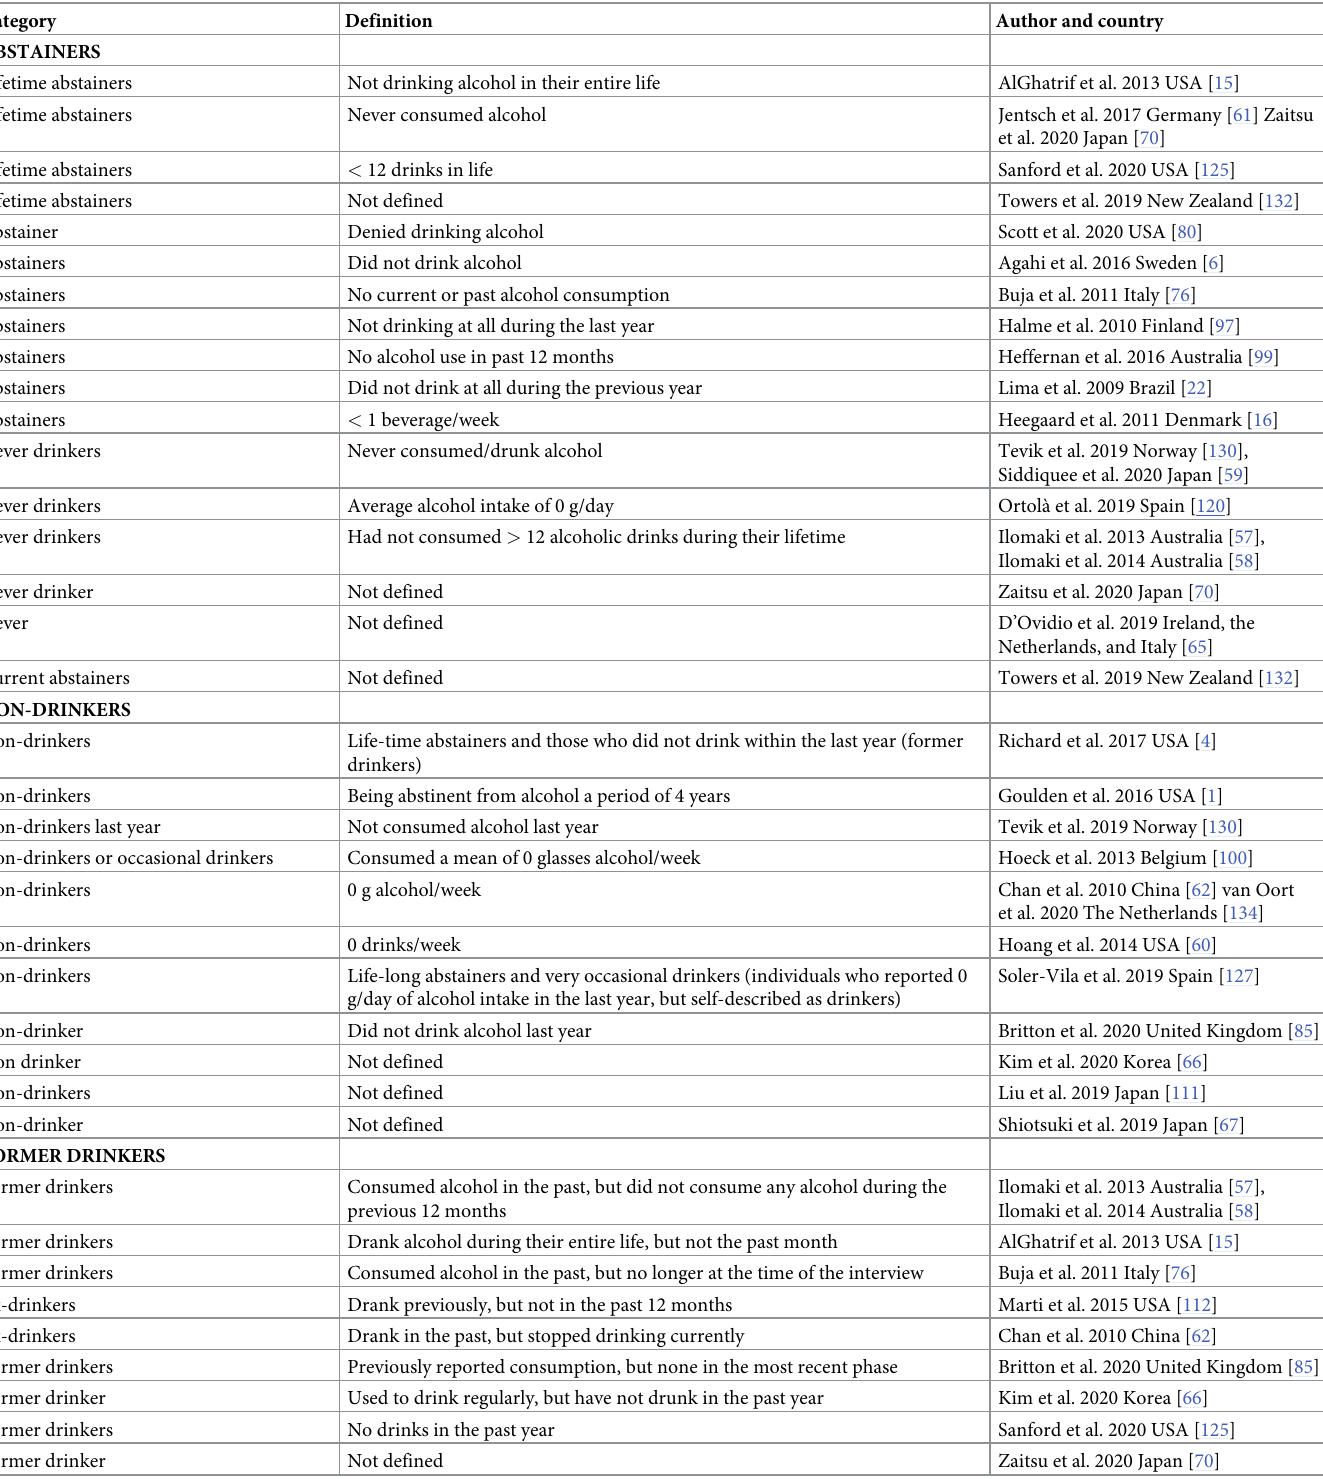
Table 6. Definitions of different pattern of alcohol